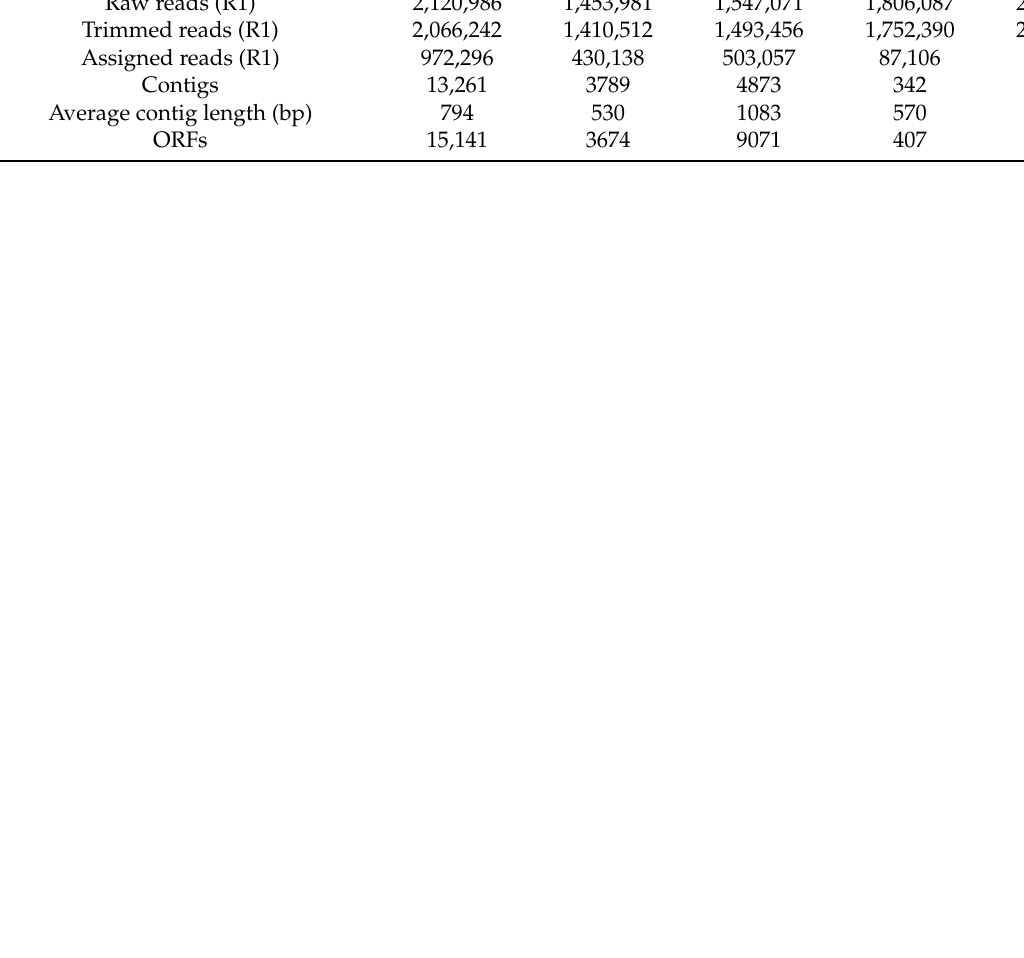
DNA RNA DNA RNA DNA